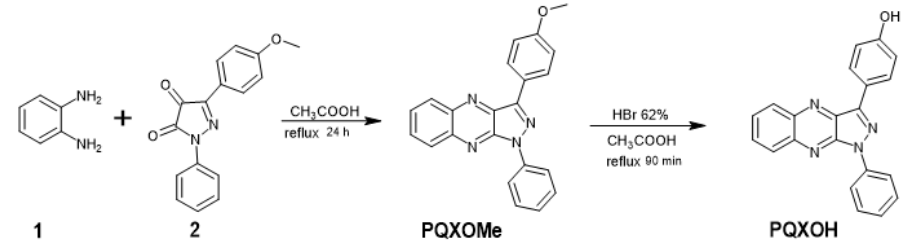
Figure 1. Reactions in synthesis of PQX-OH.